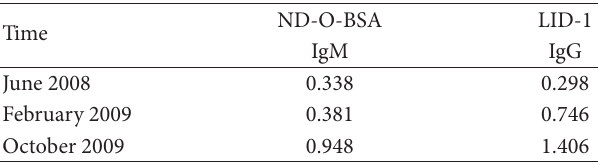
T 2: Development of antibody responses over time in a contact that developed MB